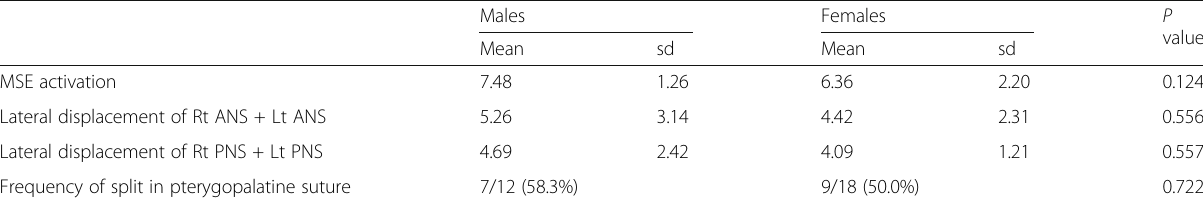
Table 3 Analysis of differences in suture opening between males and females